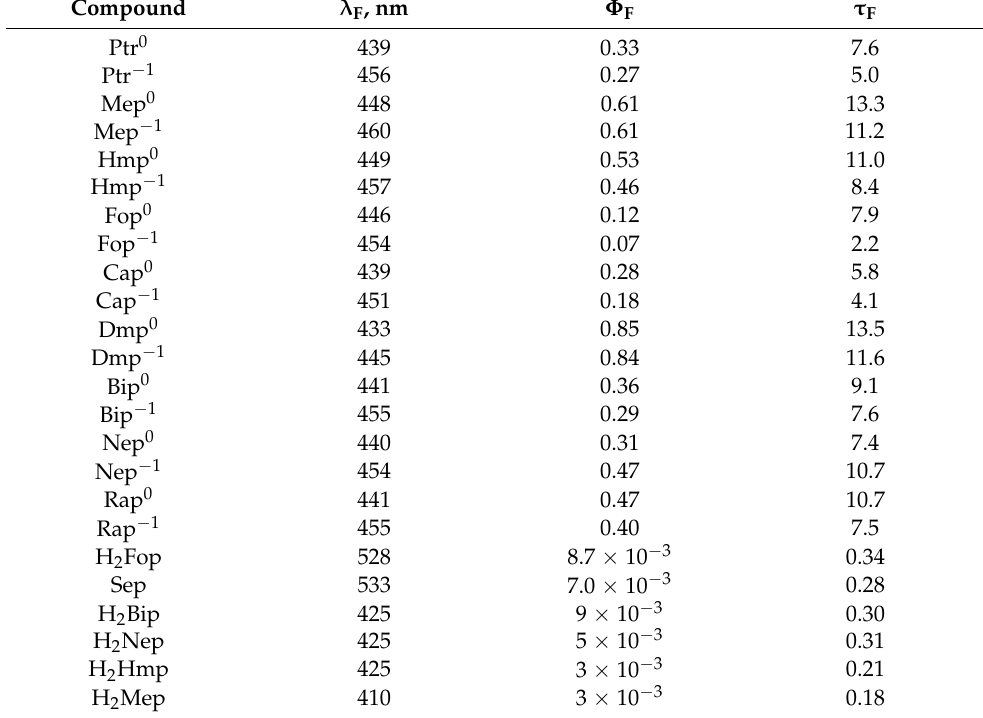
Table 1. Wavelengths of fluorescence maxima ( λ F ), fluorescence quantum yields ( Φ F ), and fluores- cence lifetimes ( τ F ) in air-equilibrated aqueous solutions of oxidized pterins [34] and H 2 pterins [185]. Compound λ F ,